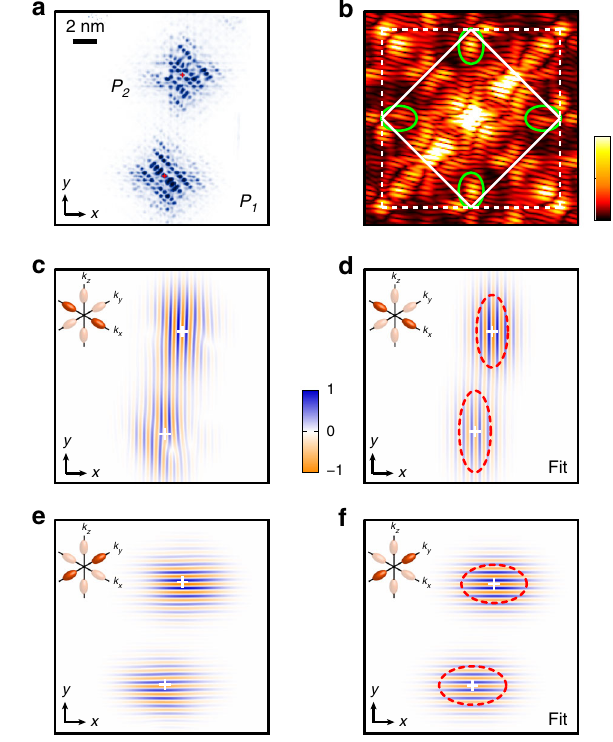
Fig. 4 Valley interference for pair #2. a Experimental STM image of pair #2. The red crosses indicate the ion locations. b FFT of the STM image, centred on the fi rst Brillouin zone. As for pair #1, the FFT shows a valley signal at 0.81 k 0 (green ellipsoids) and diagonal slices that indicate the interference, whose separation and slope is linked to the inter-donor distance and orientation. c Real-space image of the x -valley obtained by fi ltering the FFT around k k x ~ 0.81 0 , same procedure as for pair #1. Same scale as the STM image shown in a . The observed distortions in the x -valley image, notably on the right-hand side of P 1 , are attributed to an instability of the tunnelling tip during the measurement. d Corresponding fi tted image, using the same fi tting procedure as for pair #1, and from which Δ ϕ x and the ratio b / a for each donor (red dotted ellipsoids) can be extracted. e , f Same for the y -valleys. x and the